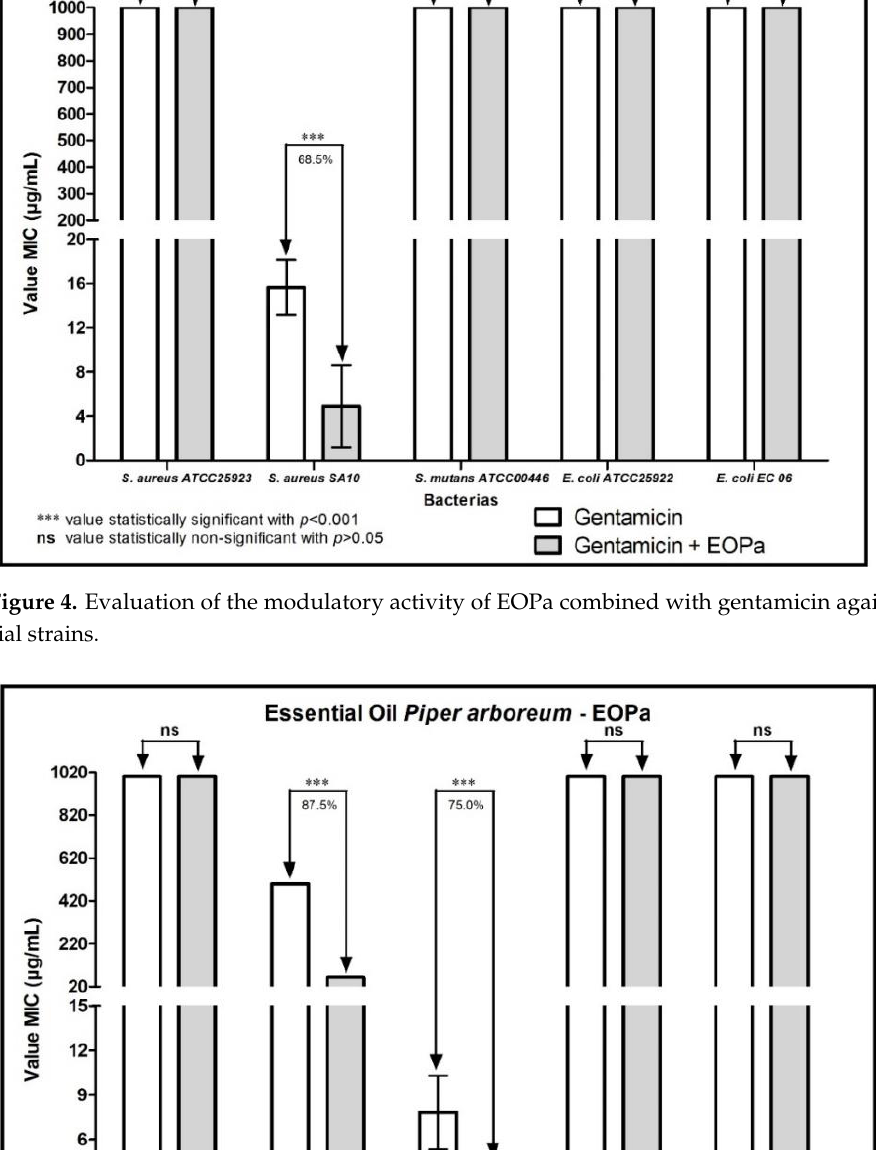
Figure 5 Evaluation of the modulatory activity of EOPa combined with penicillin G Figure 5. Evaluation of the modulatory activity of EOPa combined with penicillin G against bacte- against bacterial strains. rial